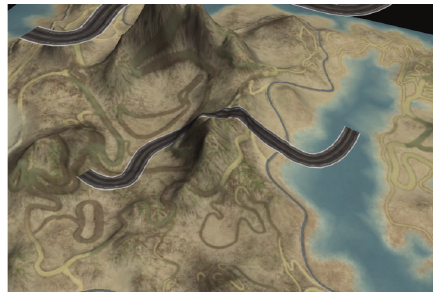
Figure 8: Track over terrain using